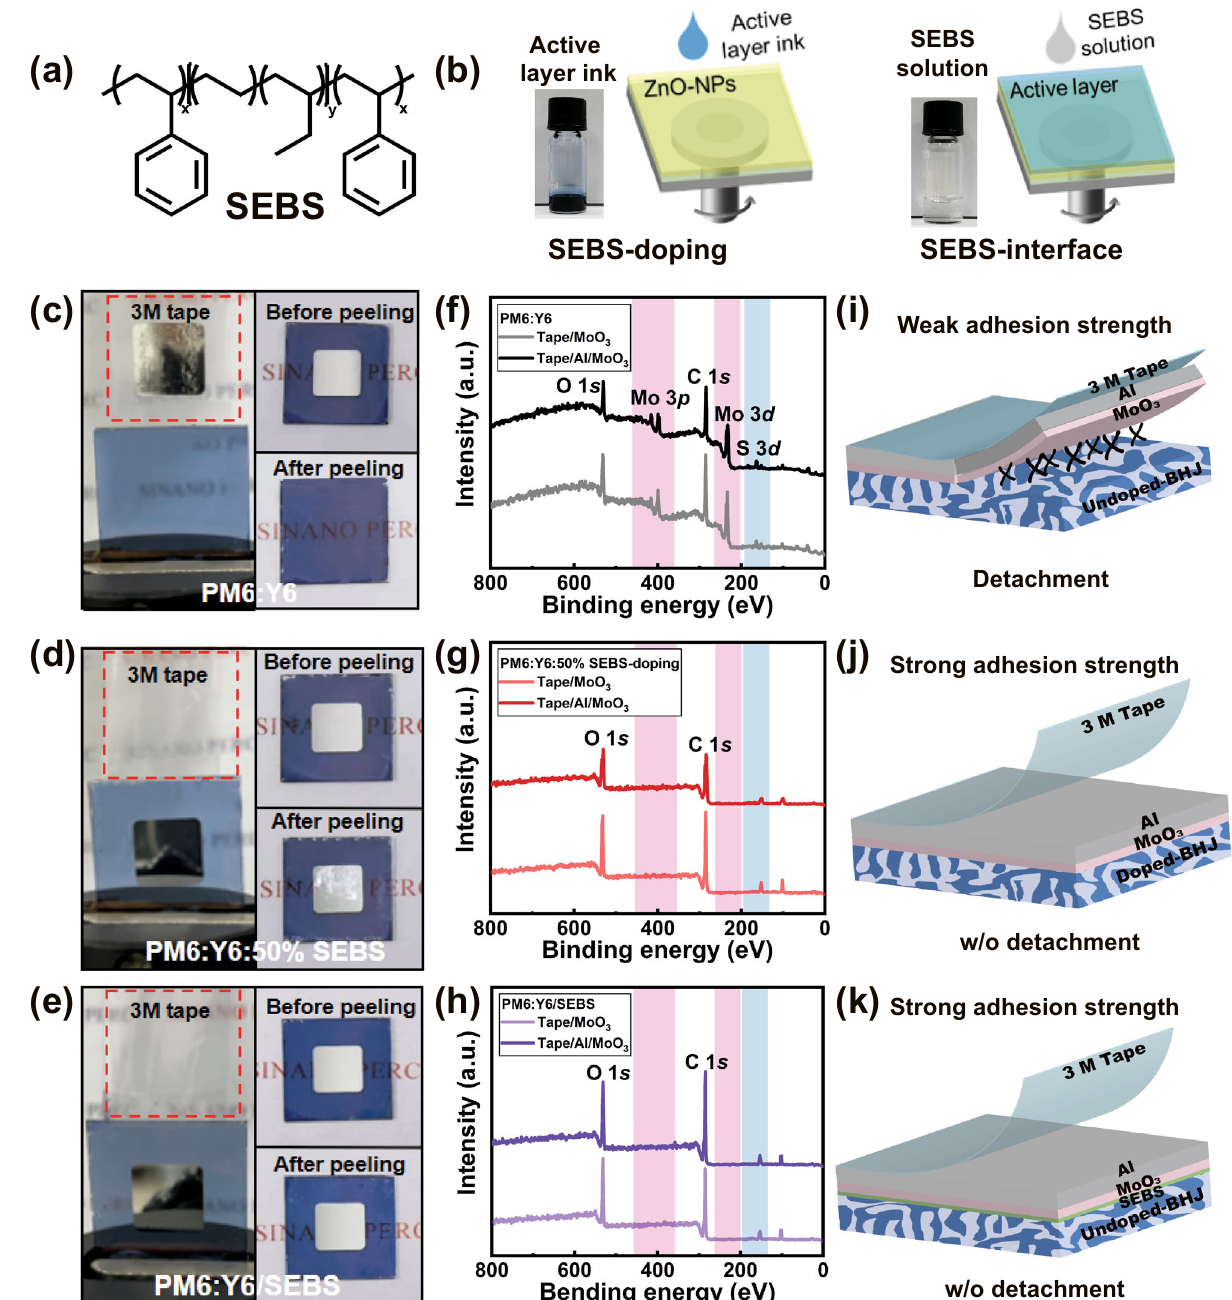
Fig. 3 Qualitative characterization of adhesion improvement. a Molecular structure of SEBS, b Schematic diagram of SEBS-doping and SEBS-interface strategies. Photographs of 3 M tape peeling measurement: c PM6:Y6 d PM6:Y6:50%SEBS, and e PM6:Y6/SEBS (8 mg mL − 1 ). XPS spectra of the remained materials on the tapes that peeled from the f PM6:Y6, g PM6:Y6:50% SEBS, and h PM6:Y6/SEBS (8 mg mL − 1 ). i – k Schematic diagram of the 3 M tape peeling